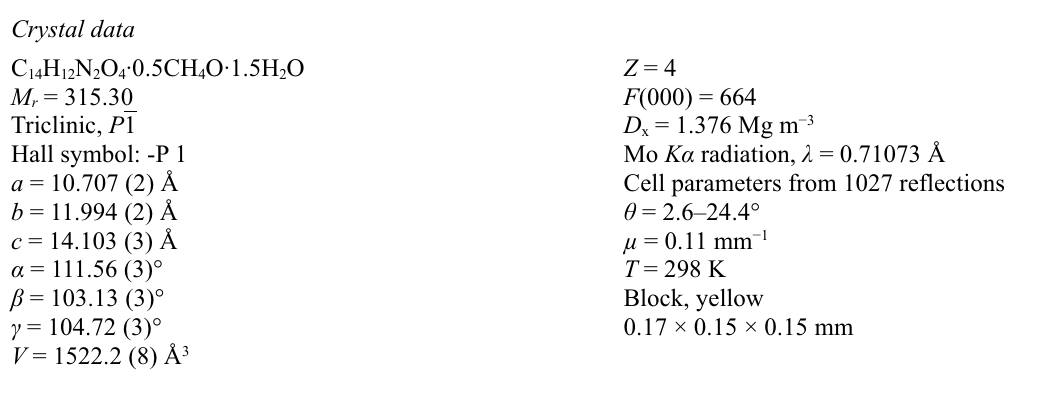
Part of the crystal packing of the title